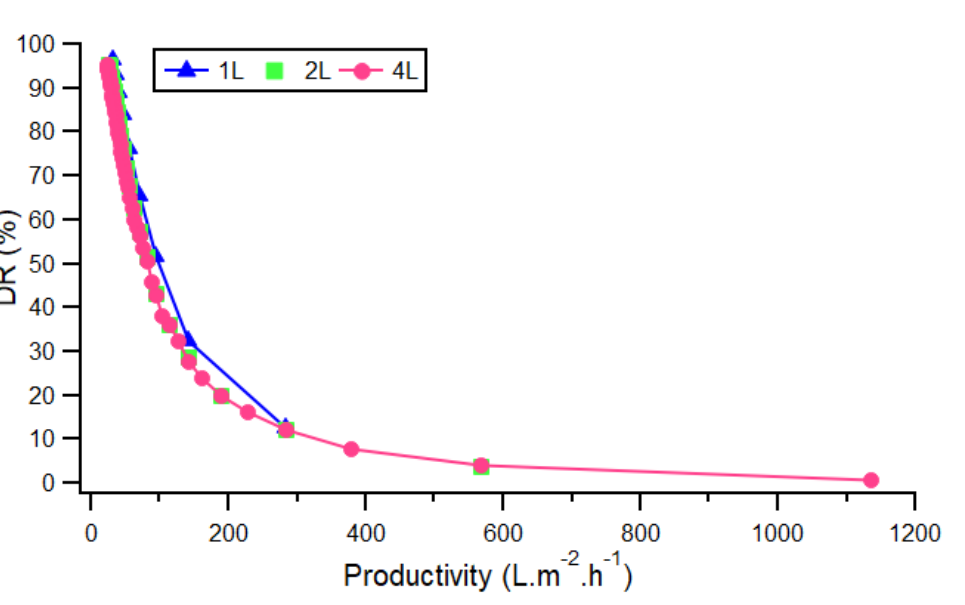
Figure 8. Relationship between demineralization rate and productivity with different volumes of dialysis RO treated.